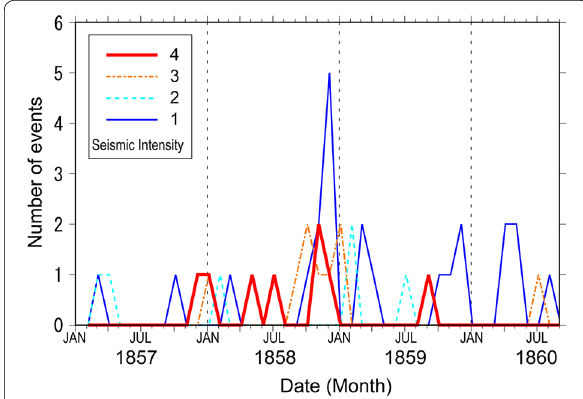
Fig. 2 Monthly number of events in each seismic intensity class. Blue, cyan dotted, orange dot dashed , and red bold lines show the monthly number of events corresponding to JMA seismic intensities of 1, 2, 3, and 4,